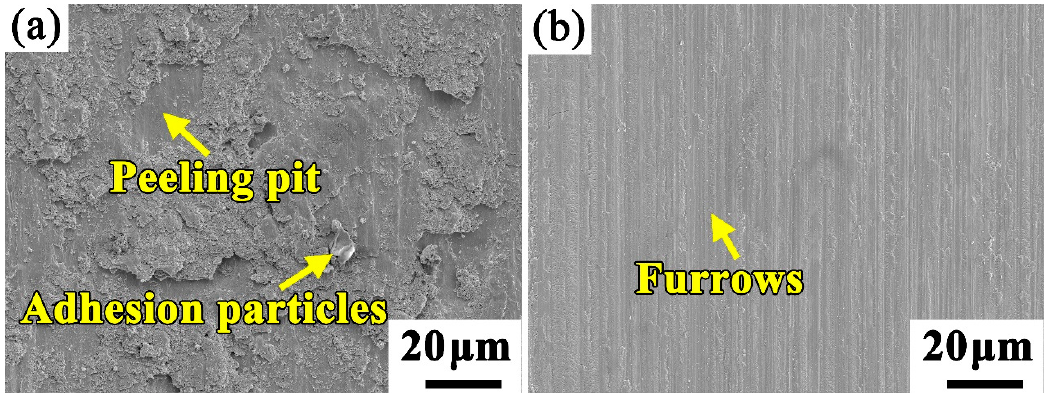
Figure 9. The morphologies of the worn surface of ( a ) substrate and ( b ) high aluminum and chromium Fe-B-C coating.